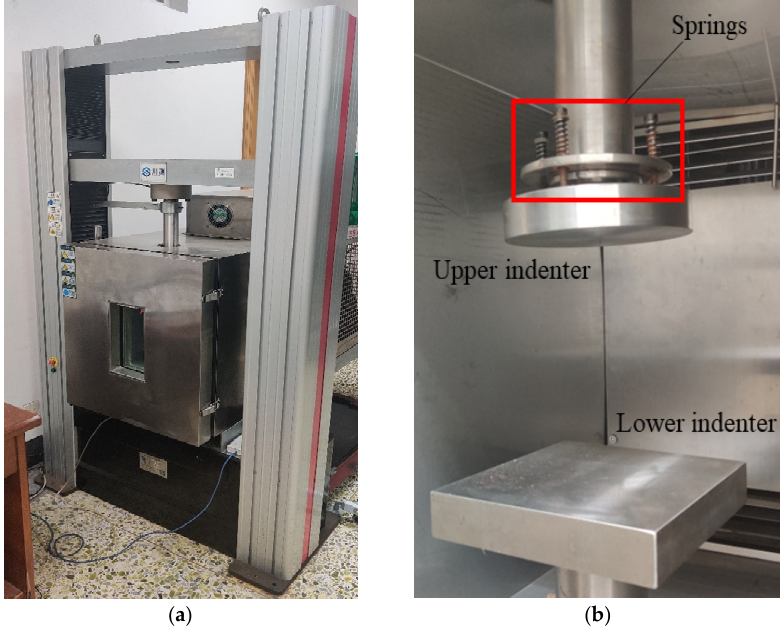
Figure 4. Test devices. ( a ) WDW-100E electronic universal testing machine. ( b ) Testing zone.